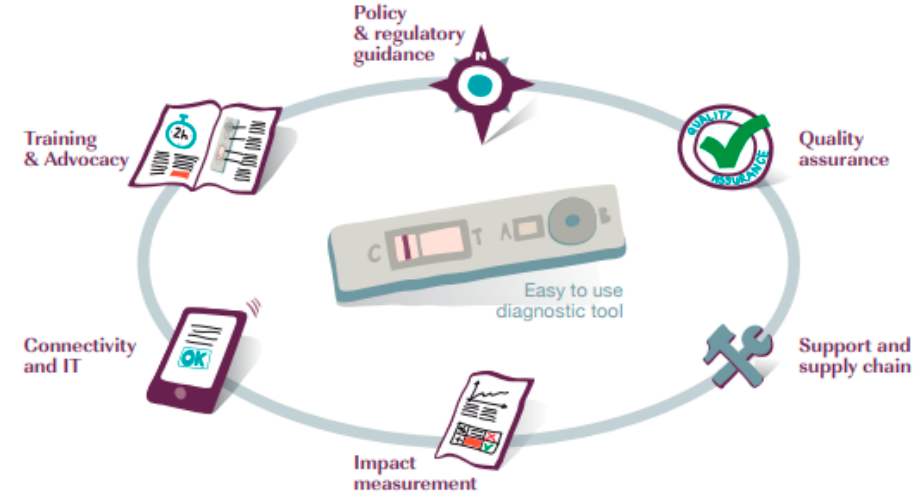
Figure 1. Elements of a complete diagnostic solution [40] (p. 23).